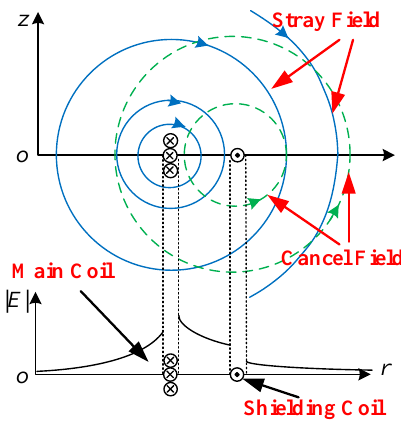
Figure 2. The schematic diagram of shielding coil working principle.